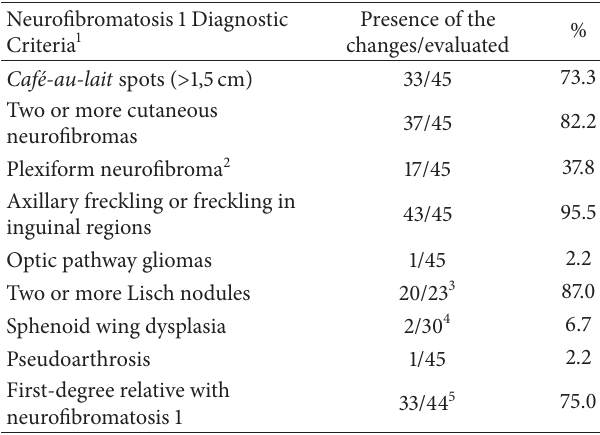
Table 2: Clinical profile of patients with clinical diagnosis of neurofibromatosis 1 in this